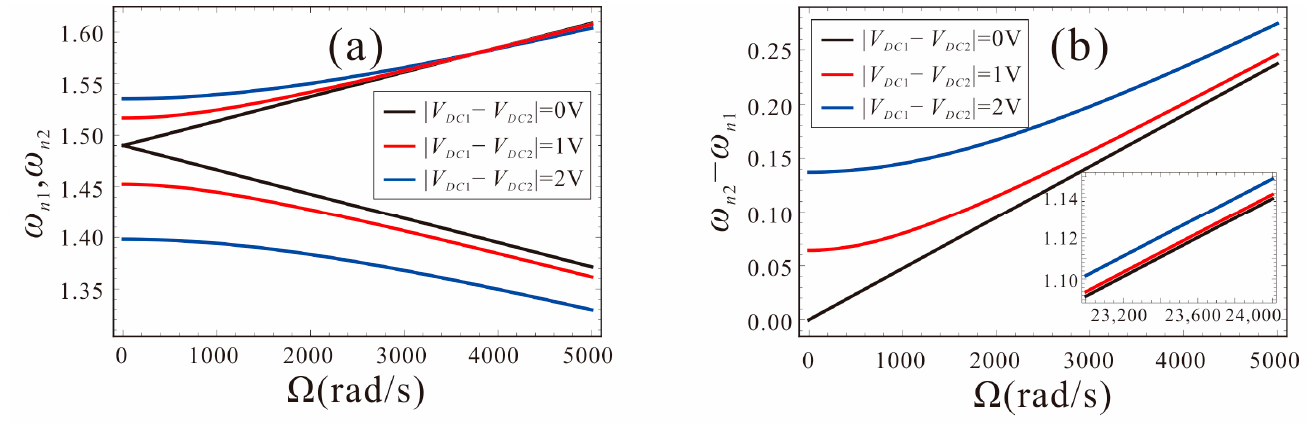
18 of 32 Figure 10. Effects of angular velocity on the natural frequency for the case of different shape factors. Table 2. Angular gain factors for FM micro-gyroscope with different shape factors. α 4 , α 5